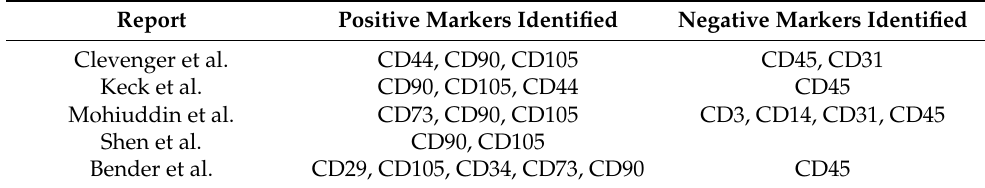
Table 3. hASC biomarkers evaluated using flow